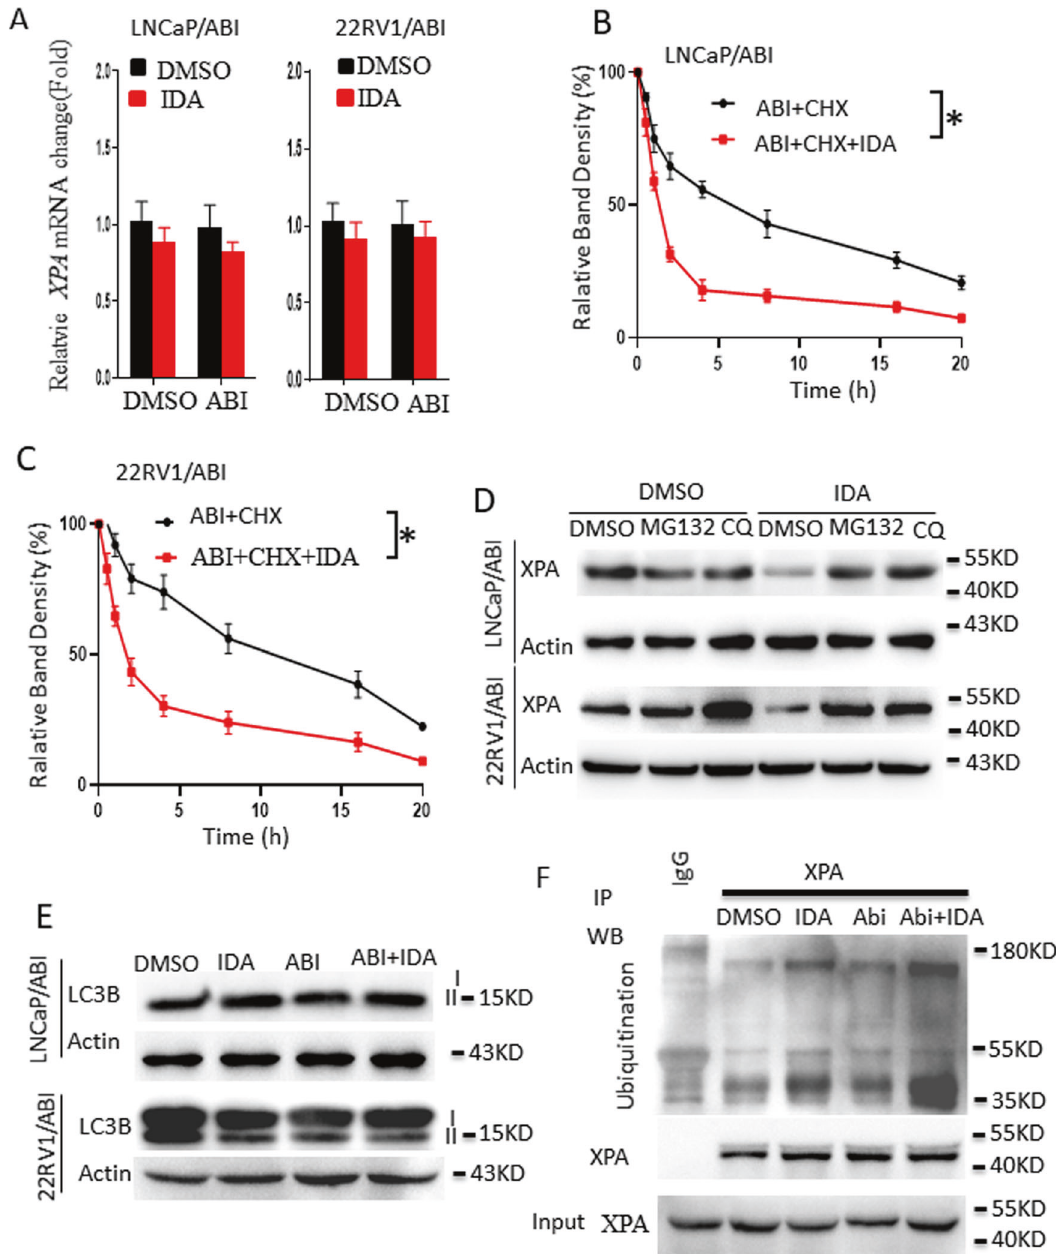
Fig. 4 IDA regulates XPA protein levels by enhancing XPA protein degradation. A LNCaP/ABI and 22RV1/ABI cells were treated with DMSO, IDA (0.25 μ M), ABI (10 μ M), and a combination of IDA with ABI for 24 h. XPA mRNA expression was determined by Real-time PCR ( n = 4). B , C LNCaP/ABI ( B ) and 22RV1/ABI ( C ) cells were treated with CHX (100 mM) alone or in a combination of IDA (0.25 μ M) in the presence of ABI(10 μ M) for the indicated periods. Band densities were determined by Image-J software, and the value at time-point 0 was set as 100%. D LNCaP/ABI and 22RV1/ABI cells were treated with DMSO, MG132, and CQ(30 μ M) with or without IDA(0.25 μ M) for 24 h. XPA protein levels were determined by western blot. E LNCaP/ABI and 22RV1/ABI cells were treated with DMSO, IDA(0.25 μ M), ABI(10 μ M), and a combination of IDA with ABI for 24 h. LC3B expressions were determined by western blot assay. F LNCaP/ABI cells were treated with DMSO, IDA(0.25 μ M), ABI(10 μ M), ABI plus IDA for 20 h. Proteasome inhibitor MG132 (1 μ M) was included in the assay to protect the ubiquitinated protein from degradation. Ubiquitination of XPA was determined by western blot. Data are presented as means ± s.e.m. Statistical analysis was performed using two-way ANOVA analysis (Two-way ANOVA, * p < 0.05). nude mice (Fig. 6A). The combination of XPA knockout with ENZ 22RV1/ENZ cells (Fig. 5F). These data indicate that IDA decreases treatment signi fi cantly inhibited tumor growth (Fig. 6B) and XPA protein levels and DNA damage by regulating XPA protein prolonged mouse survival (Fig. 6C) compared to vehicle, sgSCR, or stability. a combination of ENZ and sgSCR. These data indicate that IDA To assay the effect of XPA on ENZ-resistant prostate cancer cells shares a similar mechanism for combating enzalutamide resistance in vivo, LNCaP/ENZ (1 × 10 6 ) expressing sgSCR or sgXPA were in prostate cancer cells. injected subcutaneously into the fl anks of 8-week-old male castrated Cell Death and Disease (2022)